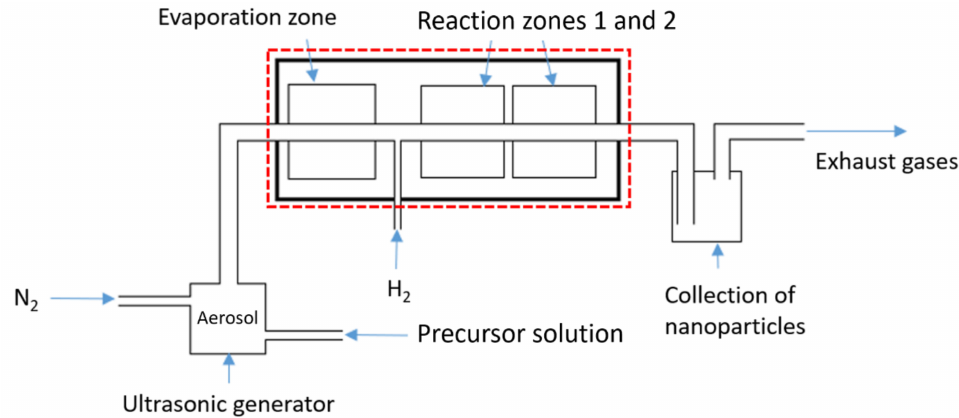
Figure 1. Schematic representation of the USP device with the part marked where the optimisation takes